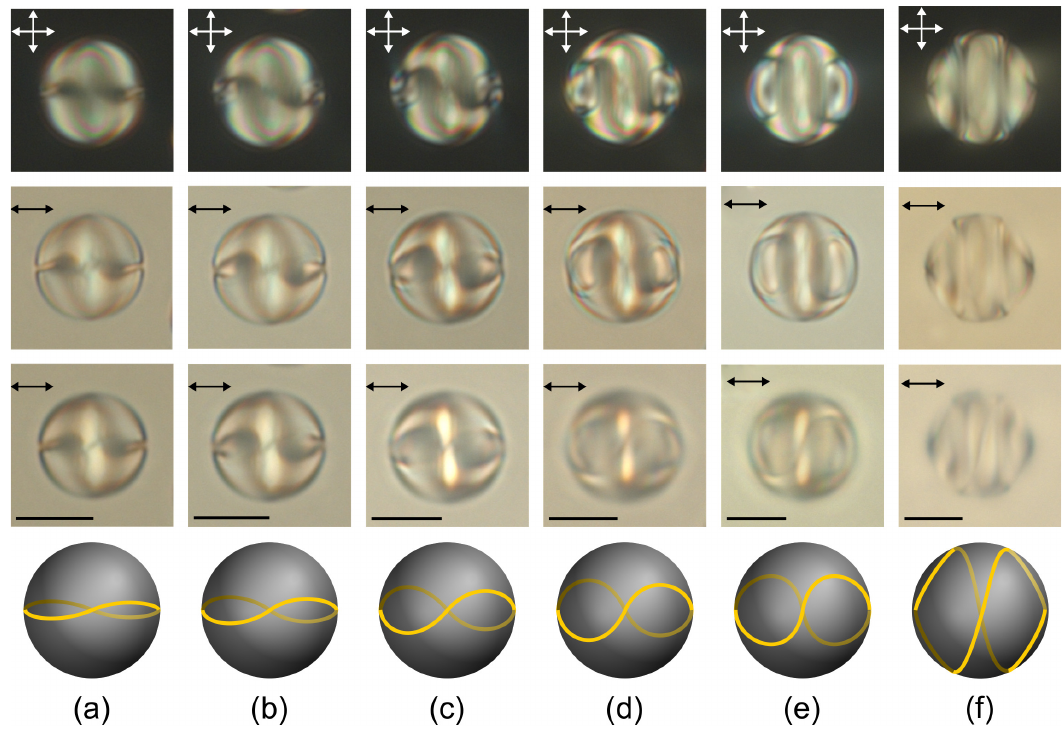
Figure 6. POM photos of cholesteric droplets at N 0 = 3.05 ( a ), N 0 = 3.25 ( b ), N 0 = 3.60 ( c ), N 0 = 3.71 ( d ), N 0 = 3.92 ( e ), and N 0 = 3.98 ( f ) taken in the crossed polarisers (first row) and without analyser when the microscope is focused on the centre (second row) and above the droplet centre (third row). Schemes of the twisted defect loops on the droplet surface (fourth row). Scale bars are 10 µ